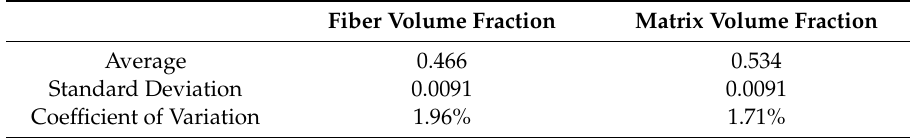
Table 1. The fiber and matrix volume fraction for the samples without carbon nanotubes.